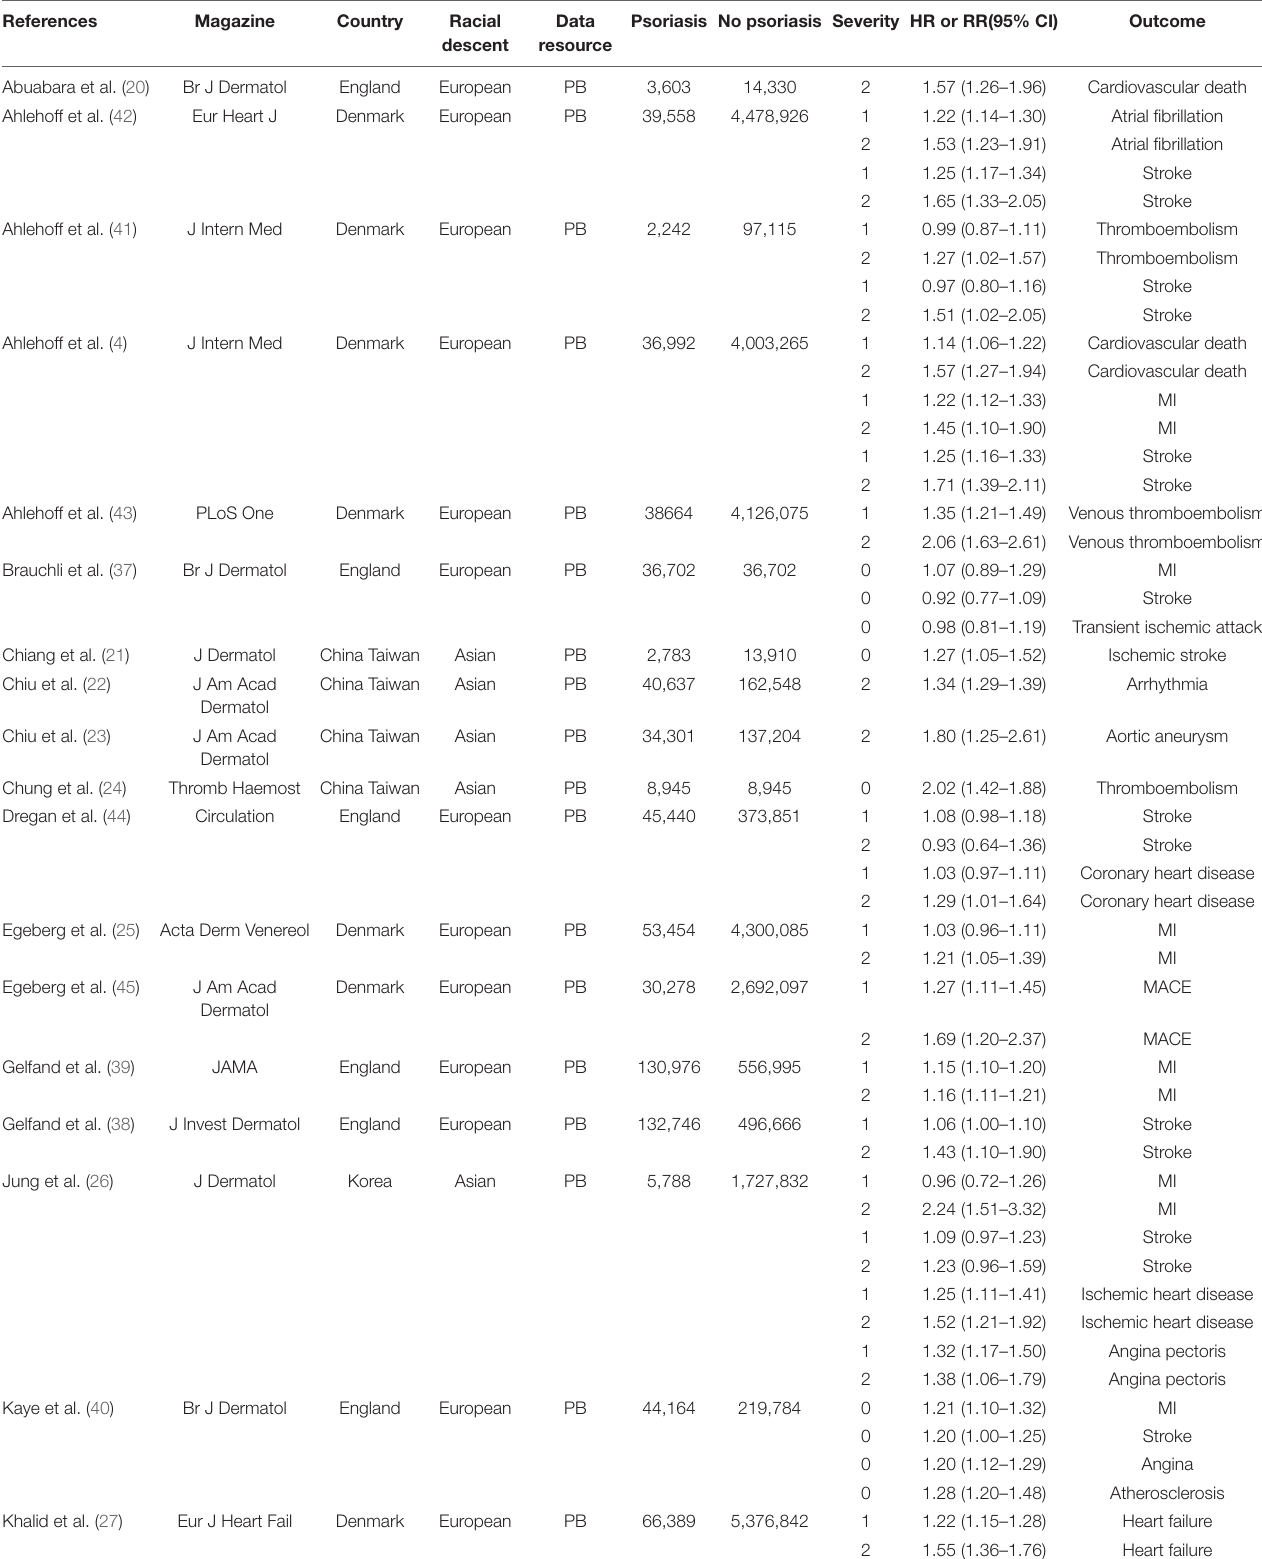
TABLE 1 | Characteristics of included studies investigated the association between psoriasis and cardiovascular diseases/events